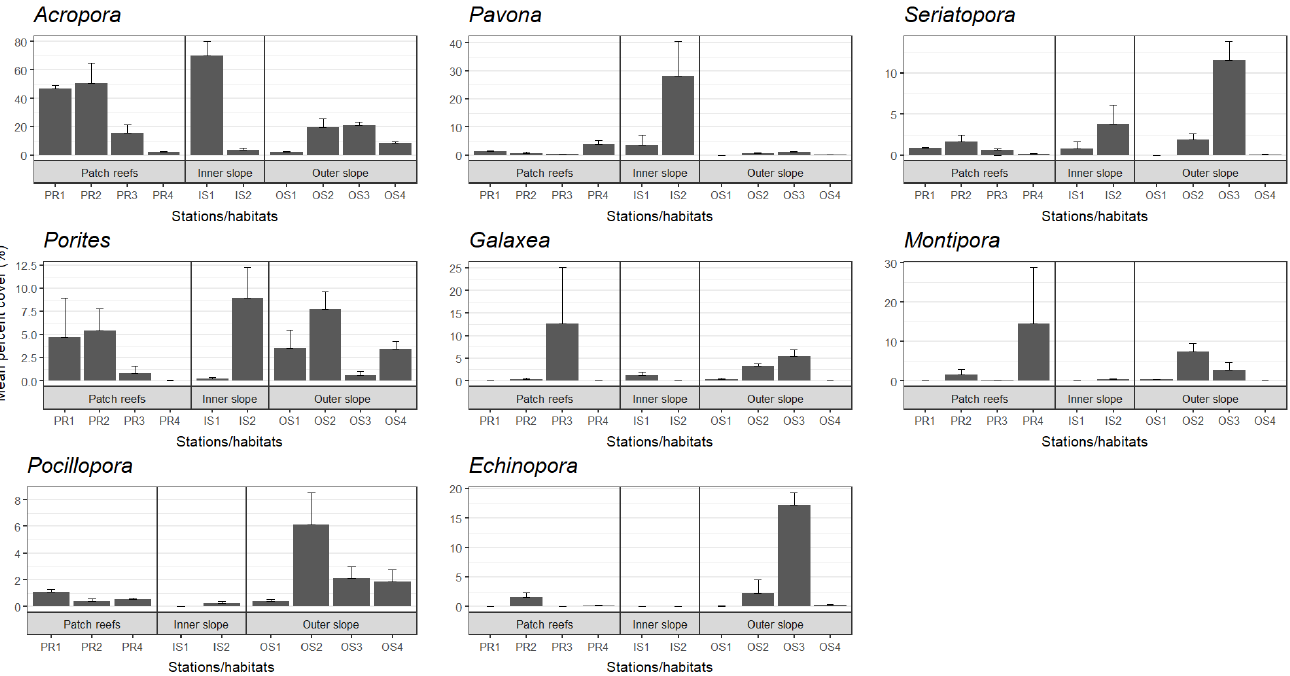
Figure 3. Mean percent cover of the eight major coral genera at the 10 stations located on the three major habitats (PR: patch reefs, IS: inner slope, and OS: outer slope). Error bars represent standard error.